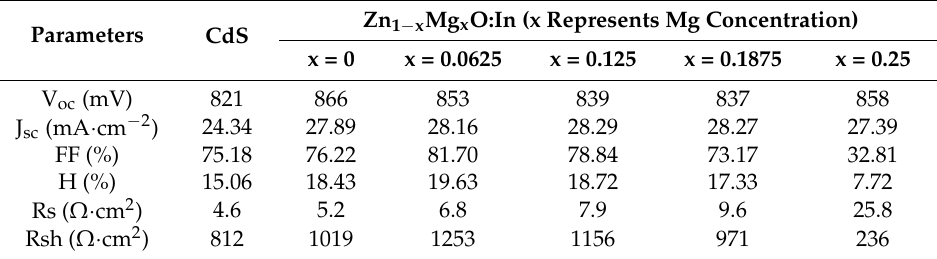
Table 2. The performances of ZMO:In/CdTe solar